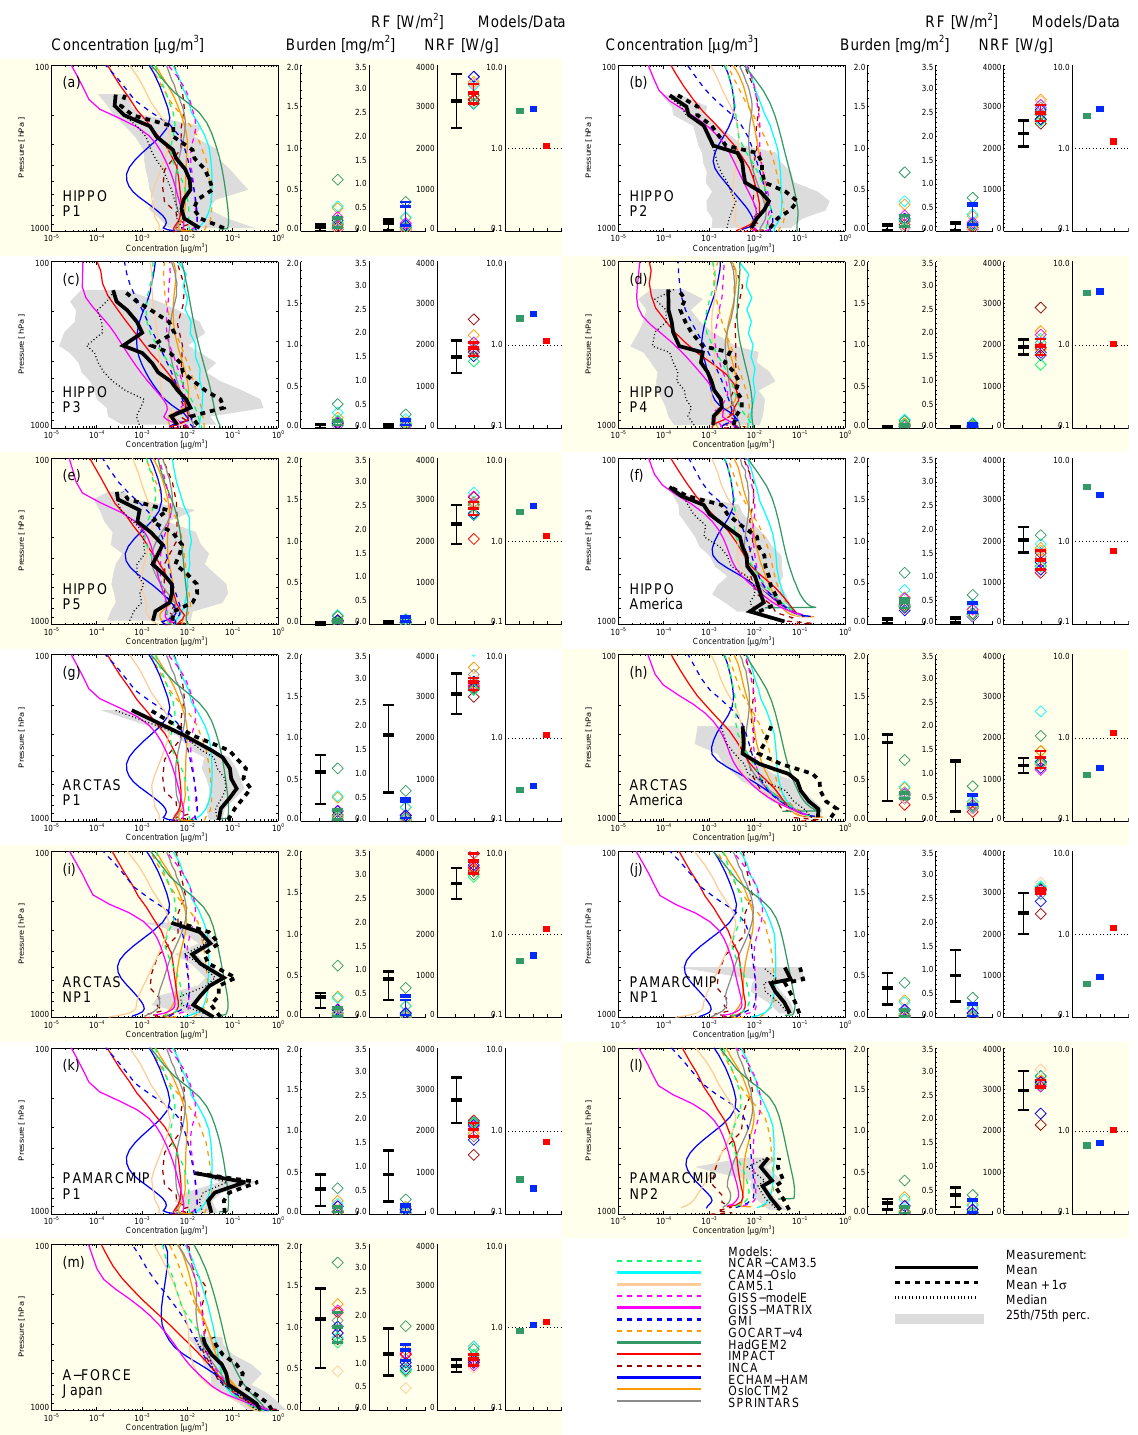
Figure 2. Comparison of measurements and model data for all selected regions. For each panel, the left box shows an overlay of the observed total BC concentration profiles – black lines: mean (solid), median (dotted) and mean + 1standard deviation (dashed), and 25th–75th percentile range (grey band) – with the mean BC concentration profiles from individual AeroCom Phase II models (coloured lines, see legend). The three middle boxes show, from left to right, the BC burden (mgm − 2 ), direct radiative forcing (Wm − 2 ) and forcing efficiency (Wg − 1 ) for observations (black) and models (red). The coloured diamonds show the individual AeroCom Phase II models. Finally, the rightmost box shows the ratio of models to observations for the burden (green), radiative forcing (blue) and forcing efficiency (red) within the selected